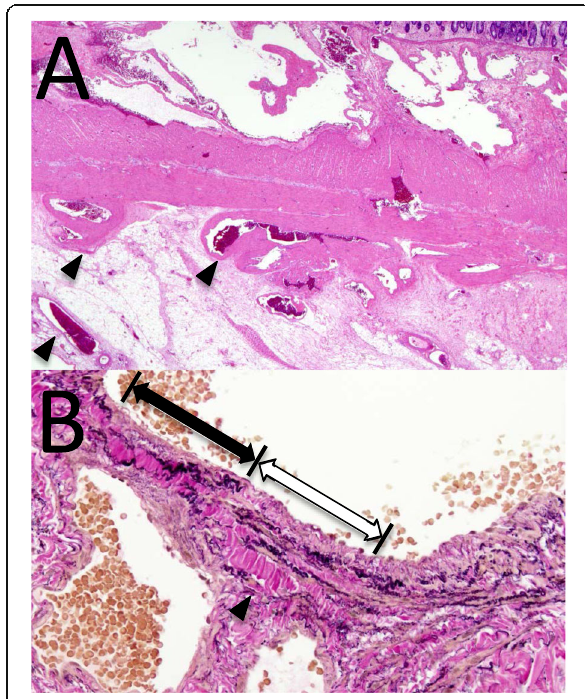
Fig. 3 Histological sections. a Abnormally enlarged and ectatic vein in the submucosa extending into the subserosa (arrow head). Hematoxylin and eosin stain. b Arterial structure with internal elastic lamina and no smooth muscle layer (black arrow) joining a venous vessel with only a smooth muscle layer and no internal elastic lamina (white arrow) certifies the diagnosis of an arteriovenous malformation. The black arrow indicates the adventitia. Elastica van Gieson